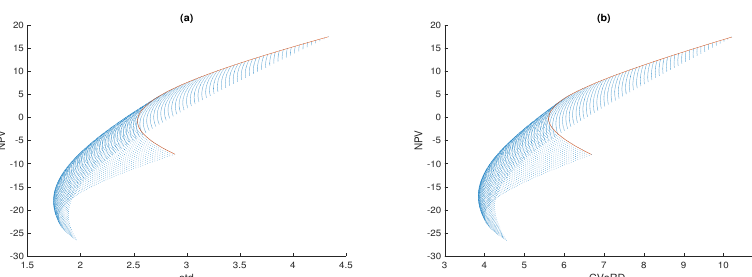
Figure 1. Power portfolio opportunity sets under the stochastic NPV metric. The 30-year plant lifetime scenario: ( a ) the standard deviation case; ( b ) the Conditional Value at Risk Deviation (CVaRD) case. In the y -axis, NPV stands for expected NPV. Continuous red lines depict two-asset, gas and coal, portfolio opportunity sets.